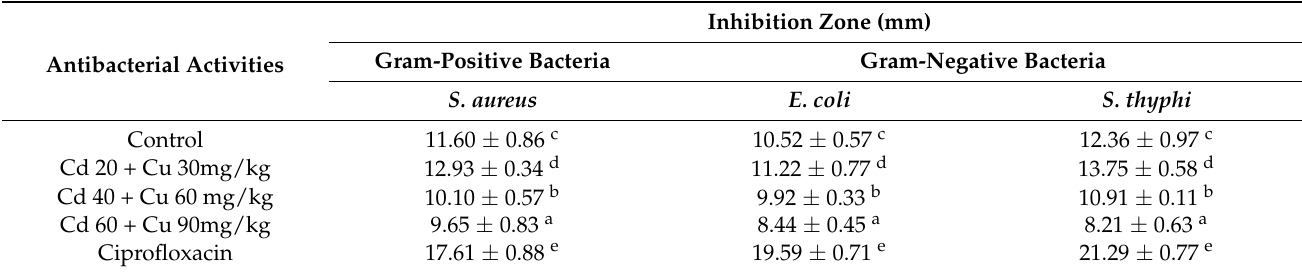
Table 3. The anti-bacterial activities of pigeon pea leave crude extracts of different Cd and Cu treatments through the disc diffusion approach. Various statistical letters represent significant differences from